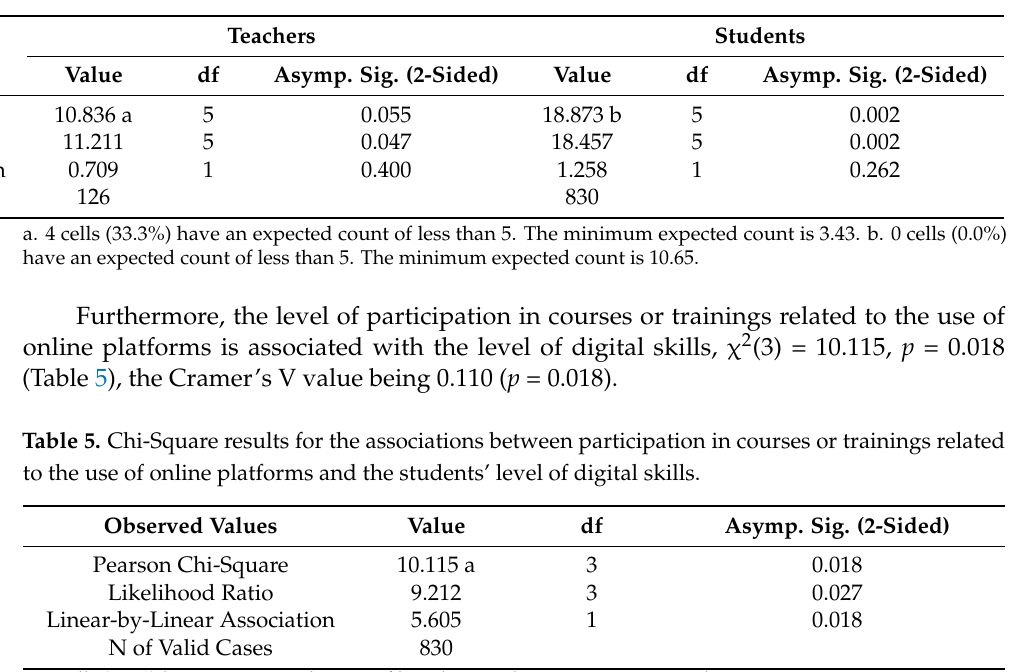
Figure 1. Participation in courses or training related to the platforms proposed by the faculty. Table 4. Chi-Square results for the associations between participation in courses or trainings related to the use of online platforms and the teachers’ and students’ level of English.